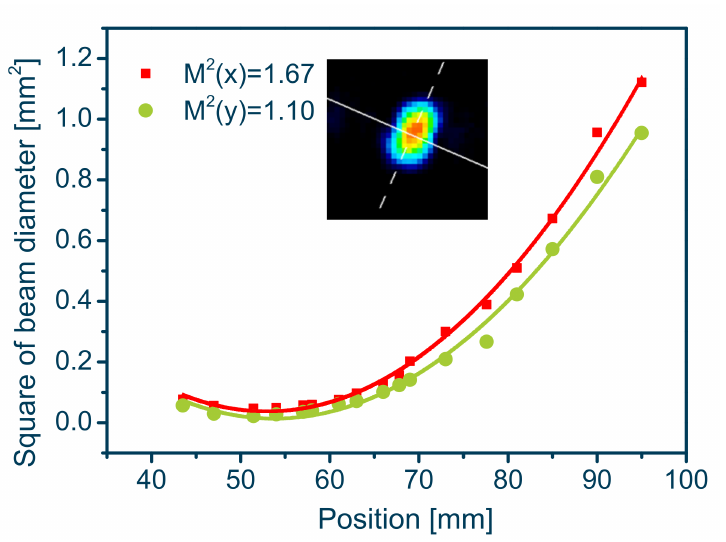
Figure 6. The beam quality factor measurement of the Tm:LuAG SCF at 2 W, the inset shows the 2D beam